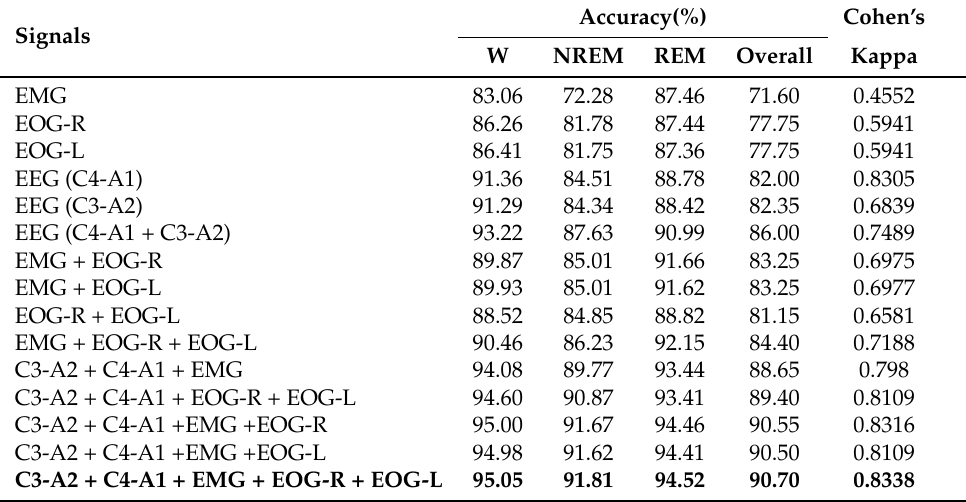
Table 2. Classification performance using different combinations of channels for classifying three sleep stages using SHHS-1.